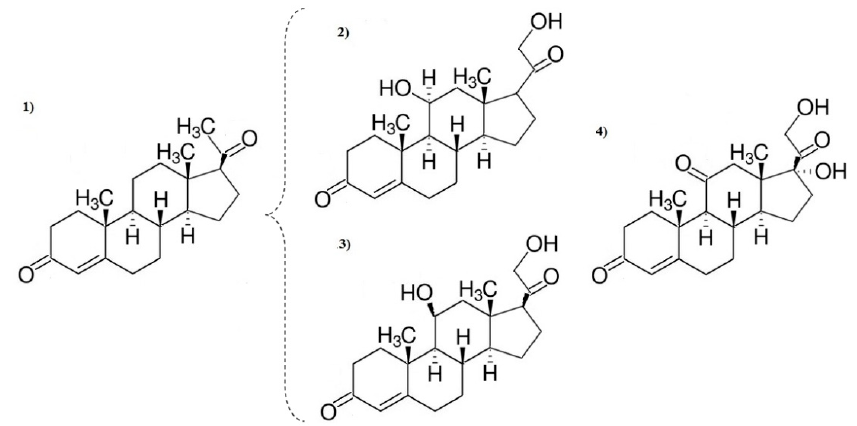
Figure 16. Identified 1 progesterone by-products: 2 , corticosterone; 3 , aldosterone; and 4 , cortisone.